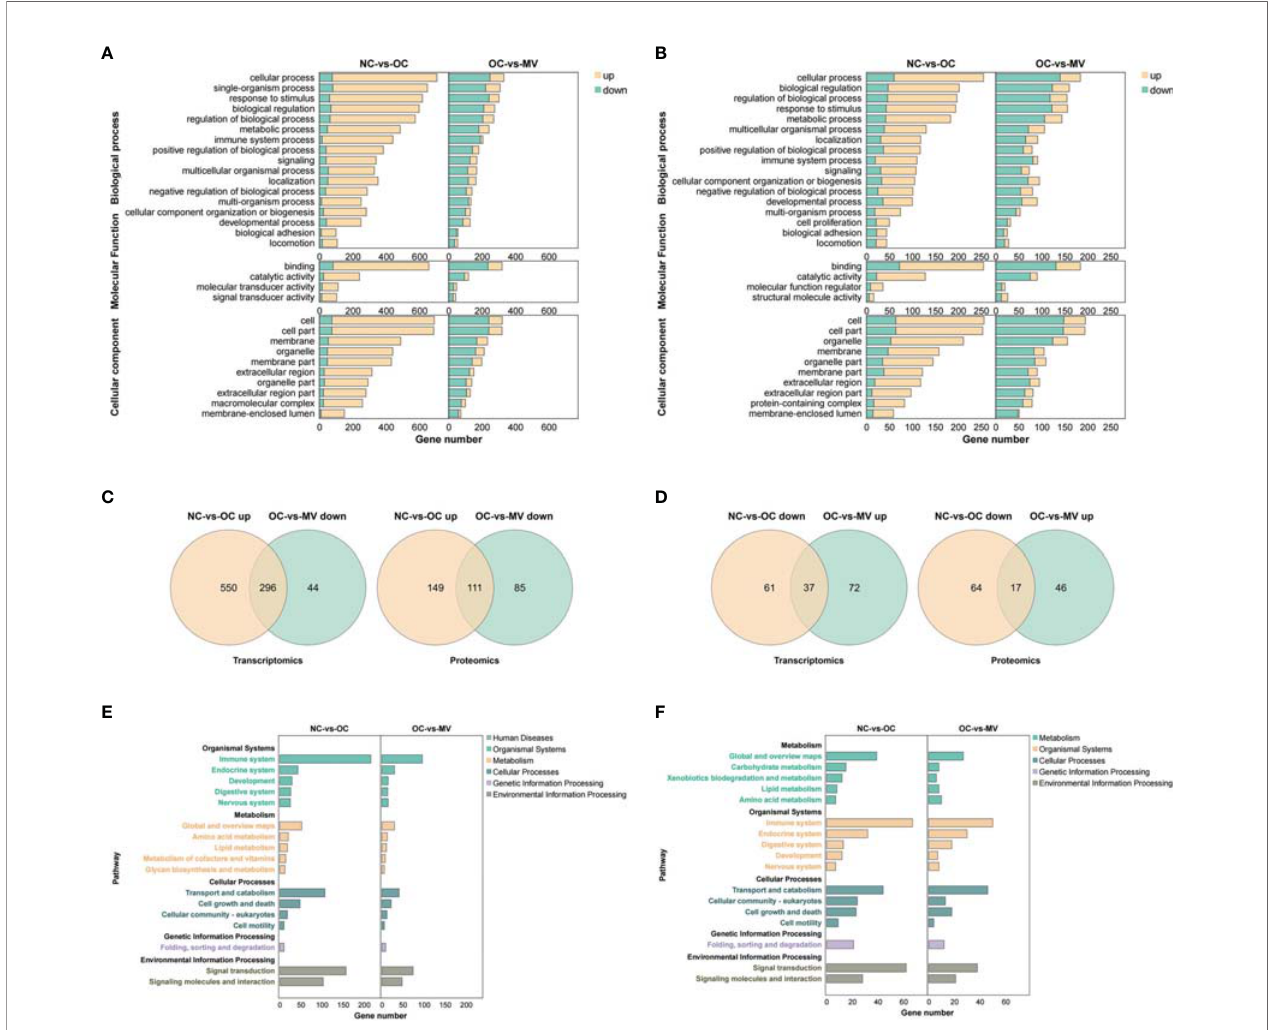
FIGURE 5 | (A) Overlapped GO in the normal control group (NC) vs. the ovalbumin control group (OC) (right) and OC vs. the group treated with 50 mg/kg mogroside V (MV) (left) at the transcriptomic level. (B) Overlapped GO in the NC-vs.-OC group (right) and OC-vs.-MV group (left) at the proteomic level. (C) Overlapped mRNAs (left) and proteins (right) between the upregulated NC vs. the OC group and decreased OC-vs.-MV group. (D) Overlapped mRNAs (left) and proteins (right) between the decreased NC-vs.-OC group and upregulated OC-vs.-MV group. (E) Overlapped KEGG pathways in the NC-vs.-OC group (right) and OC-vs.-MV group (left) at the transcriptomic level. (F) Overlapped KEGG pathways in the NC-vs.-OC group (right) and OC-vs.-MV group (left) at the proteomic